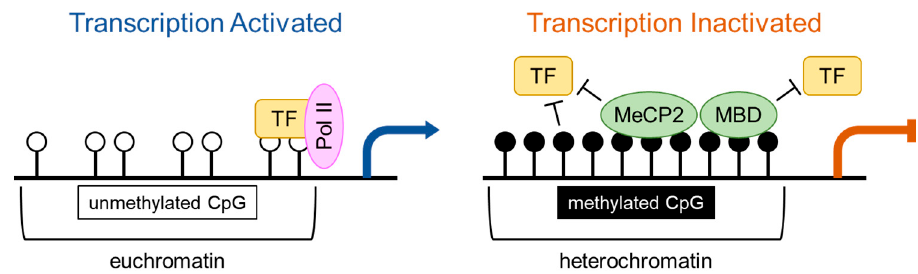
Figure 2. DNA methylation mediates gene silencing. In euchromatin (loose or open chromatin), cytosine-phospho-guanine dinucleotide (CpG) sites are generally unmethylated in promoter region and accessible to transcription factors (TFs). Methylation of cytosine in CpG sites is associated with heterochromatin (tight or closed chromatin) that typically results in silencing of gene transcription. Methylated CpG prevents the binding of TFs directly or indirectly by interacting with readers of DNA methylation, such as methyl CpG binding protein-2 (MeCP2) and methyl-CpG-binding domain (MBD). Pol II indicates DNA-dependent RNA polymerase II.